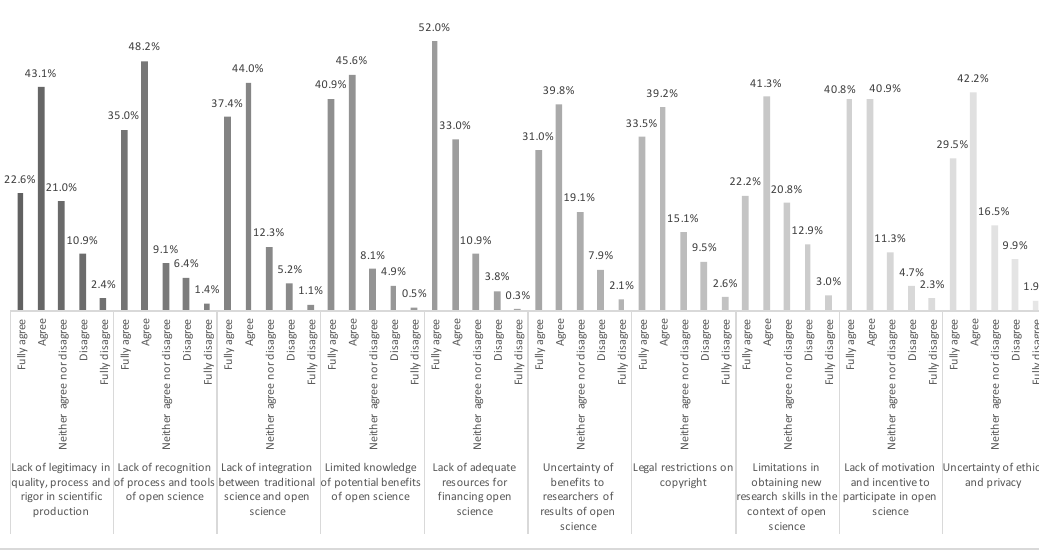
Figure A3. The main implications of open science, according to Colombian researchers.